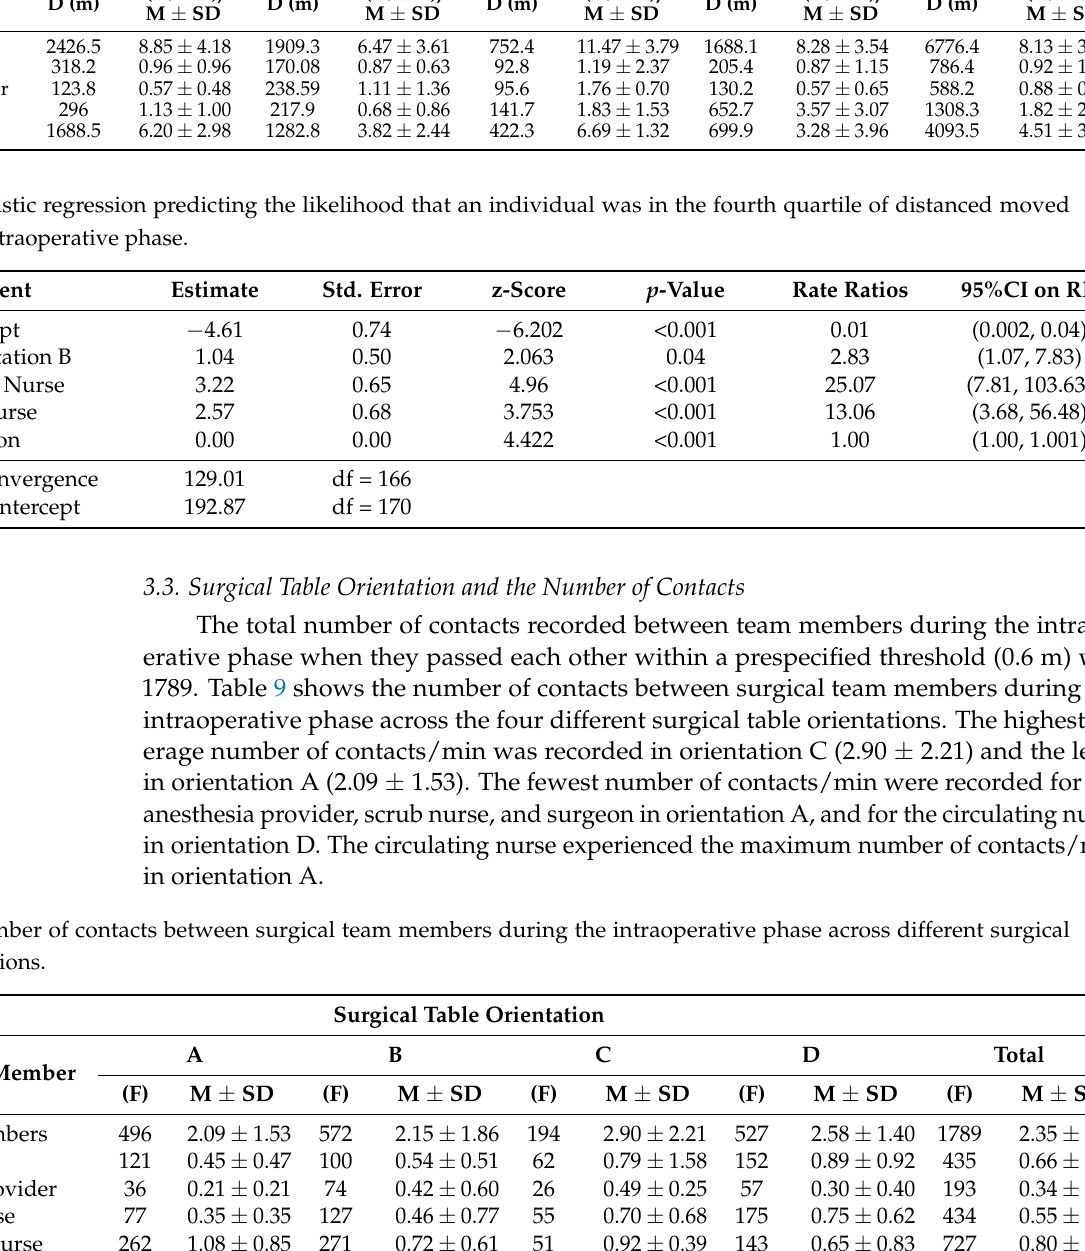
Table 7. Distance traveled by surgical team members during the intraoperative phase across different surgical table orientations. Surgical Team Member